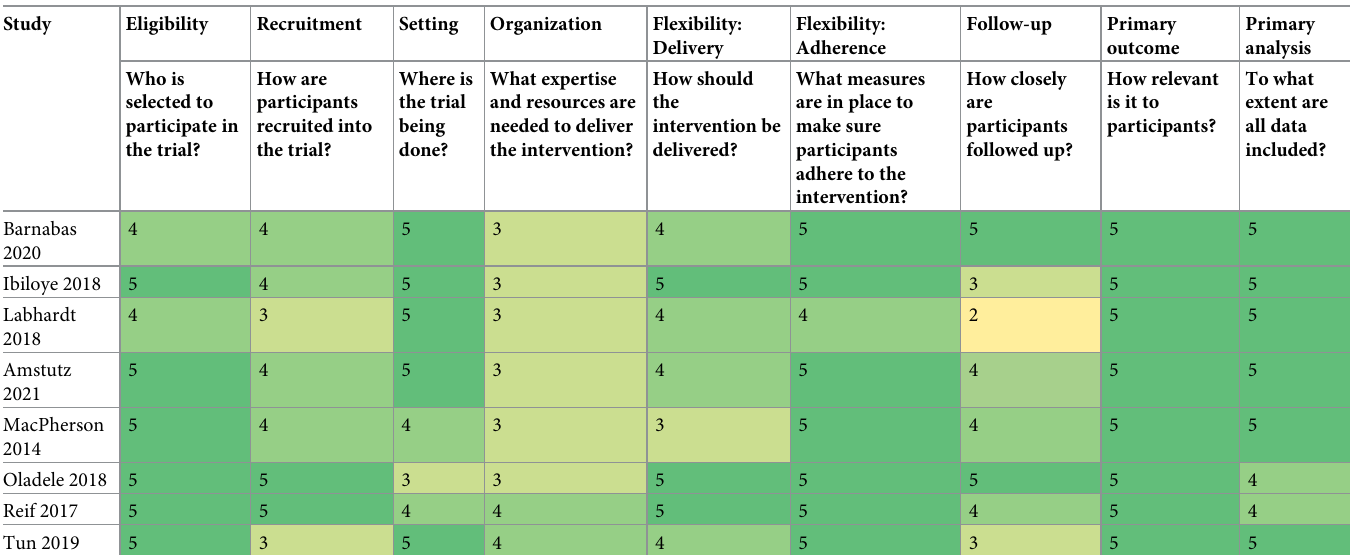
Table 4. PRECIS-2 criteria/score.